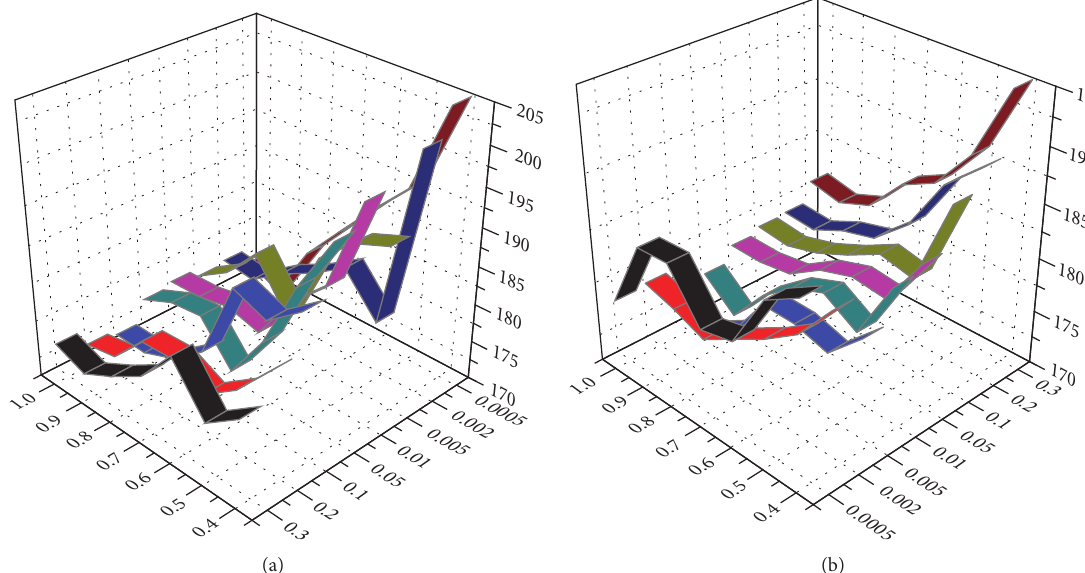
Figure 9: Effect of variations of CP and MP on the performance of gGA (a) and ssGA (b).